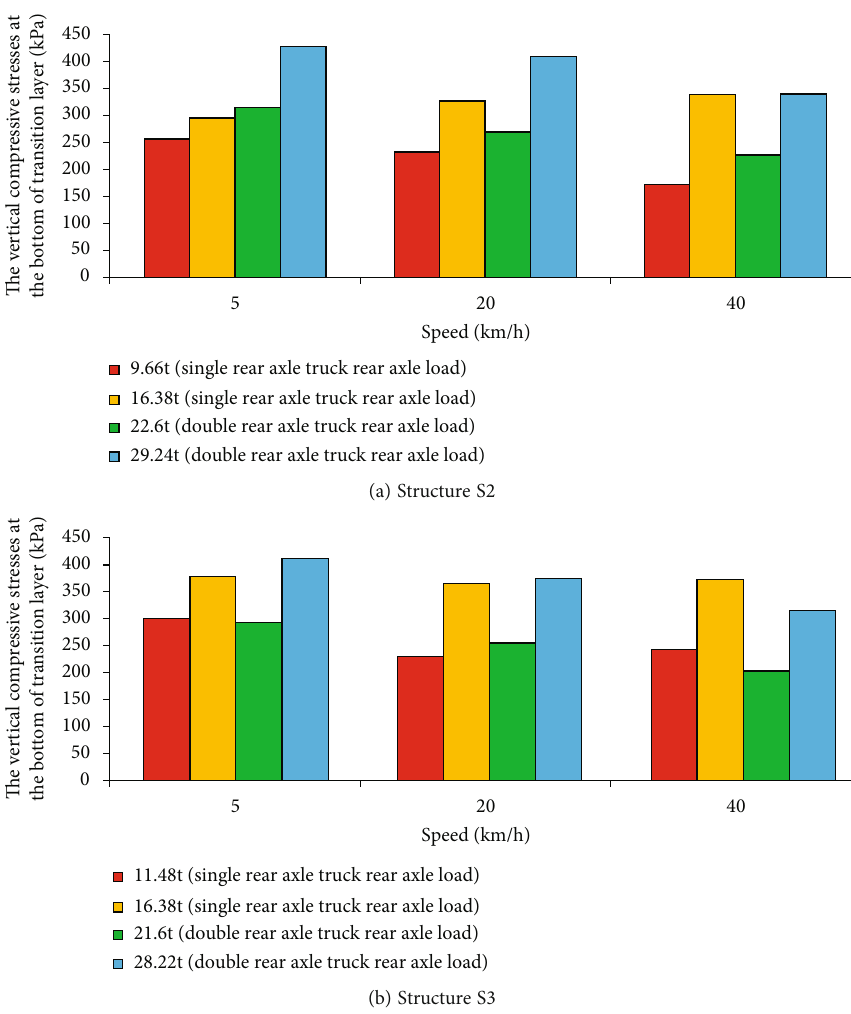
Figure 8: Relation between vertical compressive stresses at the bottom of transition layer and axle